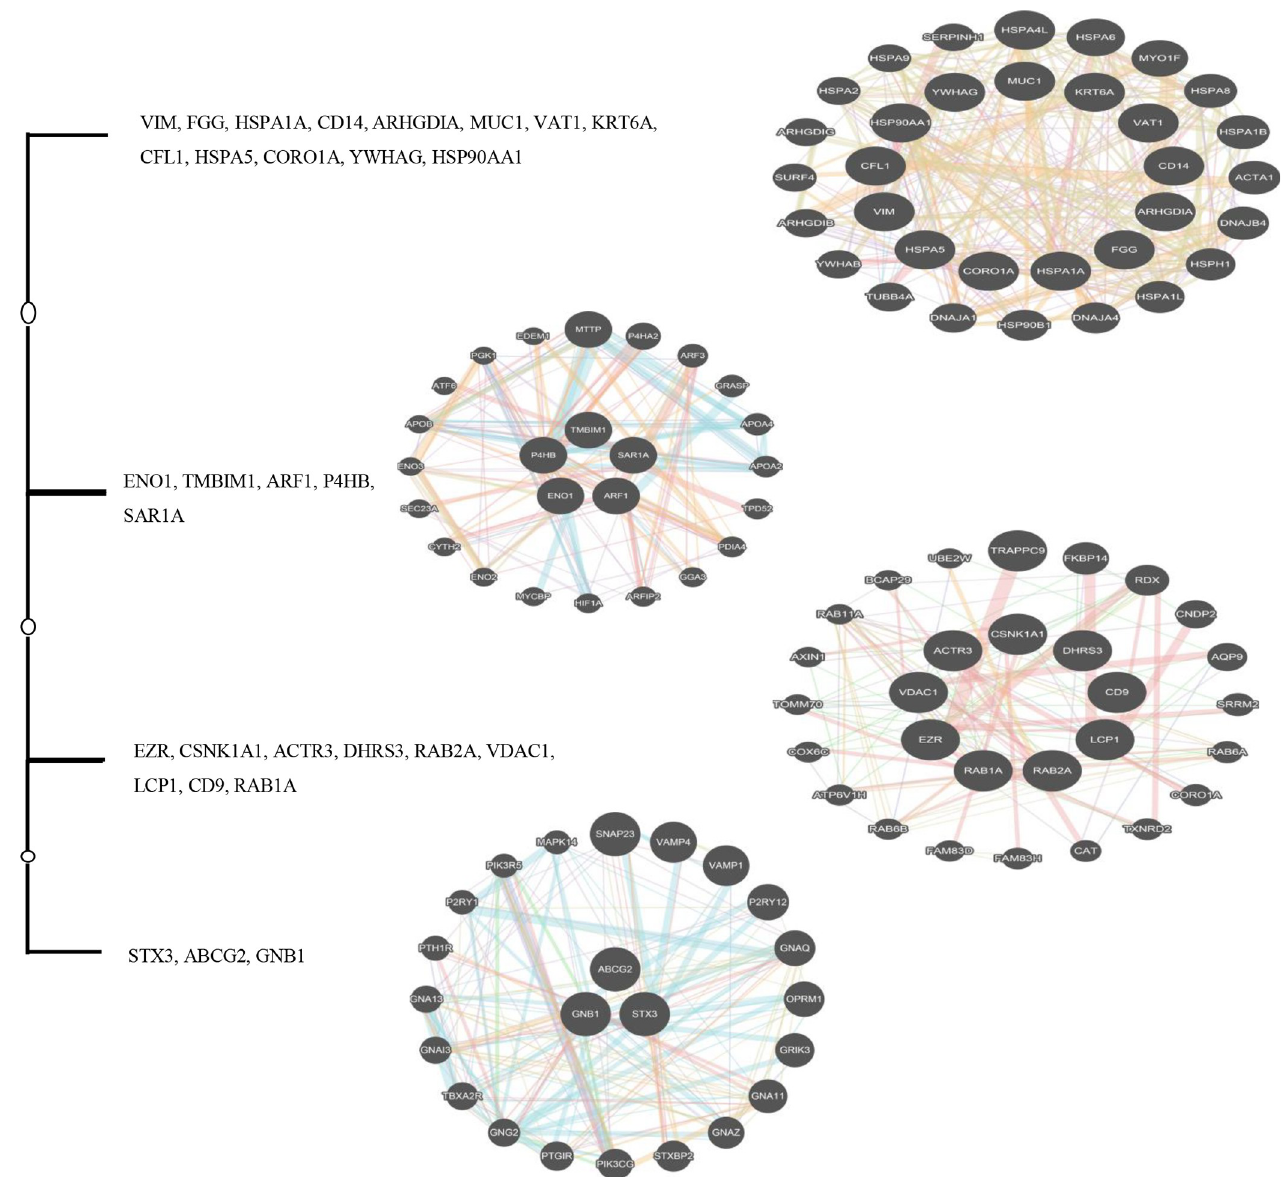
Fig 6. Evidence accumulation integration of different gene